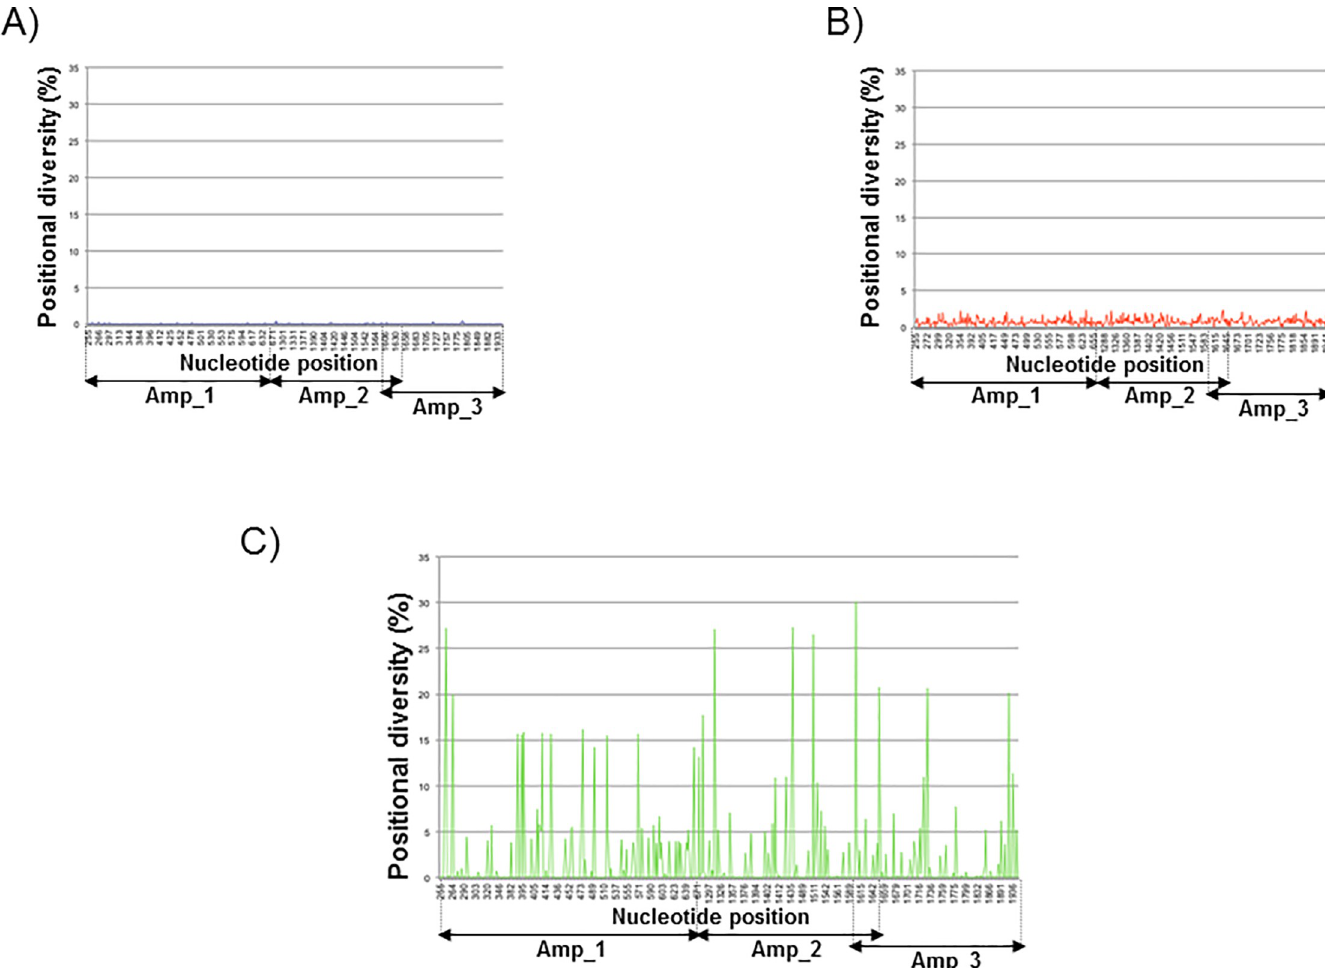
Fig 2. Positional diversity detected by deep-sequencing in parental virus AC10_29 (A) and the mutant library before [L; (B)] and after selection by the R.I.S. method [4E10sL; (C)]. (A) Amplicon sequencing of the original primary isolate before random mutagenenesis of the env gene revealed a homogeneous population. (B) The library generated by random mutagenesis had a wide variability of mutations across the amplicons sequenced. (C) Some mutations are fixed after selection with 4E10 by the R.I.S. method. Positional diversity is calculated as the frequency of all nucleotides that differ from the parental strain (AC10_29) at each evaluated position. Insertions and deletions are taken into account. Genomic regions corresponding to each amplicon are